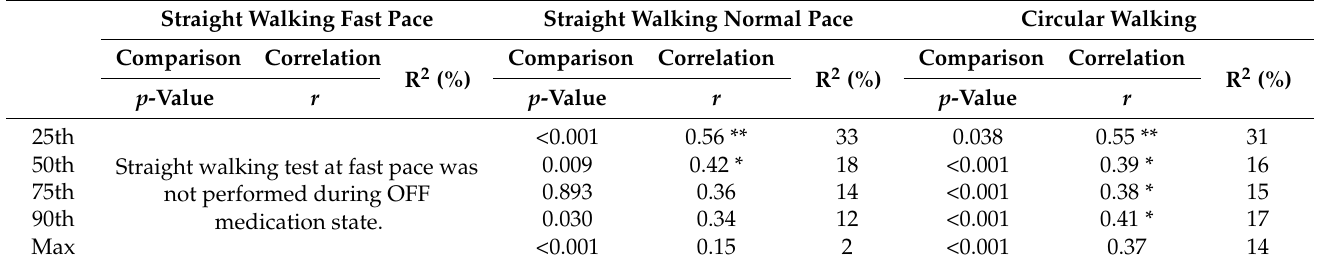
Straight Walking Normal Pace Circular Walking Comparison Correlation Comparison Correlation Comparison R 2 (%)